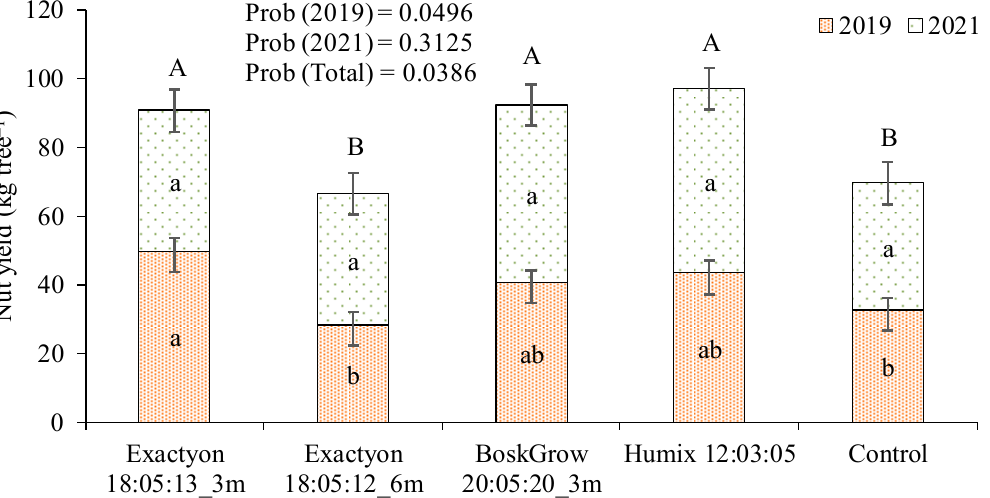
Figure 4. Average chestnut yield and standard errors in 2019 and 2021 as a function of fertilization treatments. Within each year (lowercase) and in total (uppercase), means followed by the same letter are not significantly different according to the Tukey HSD test ( α = 0.05).